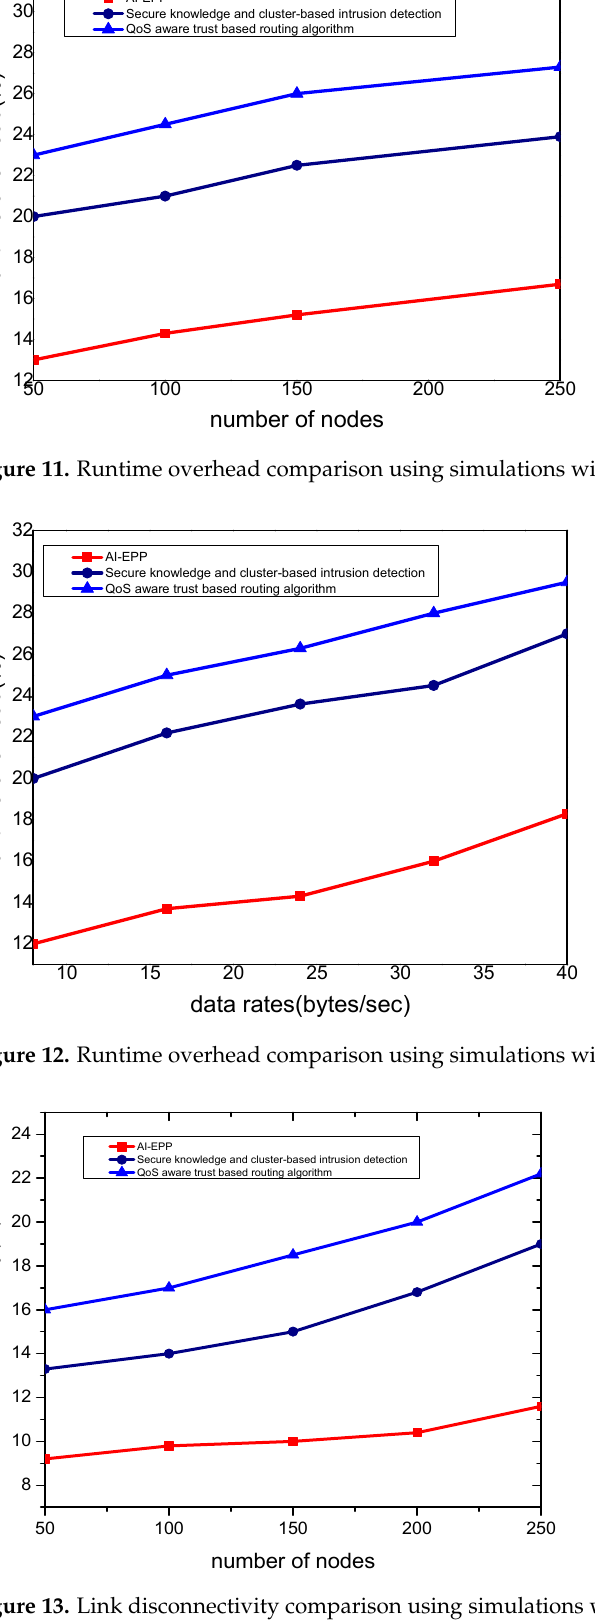
Figure 13. Link disconnectivity comparison using simulations with varying number of nodes.